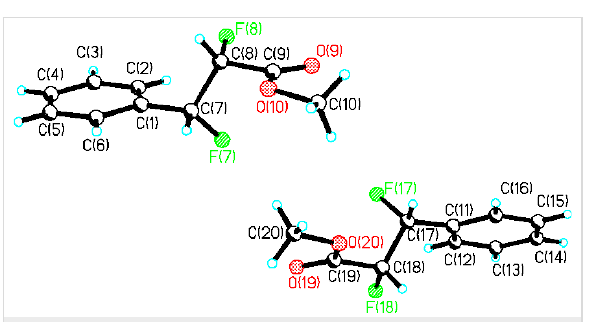
Figure 9: X-ray structure of methyl threo - 21 .